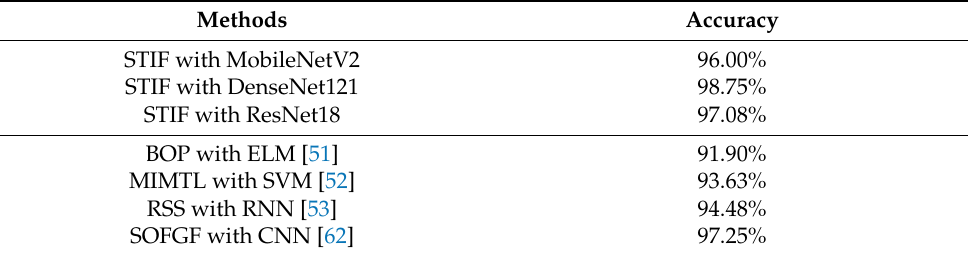
Table 6. Performance comparisons of human action recognition using MSR-Action3D